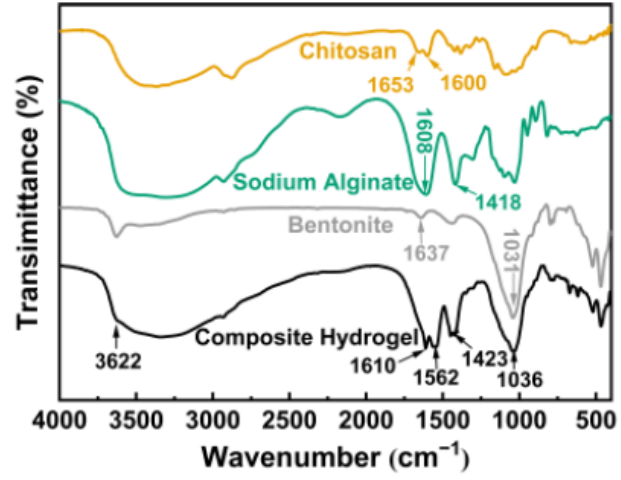
Figure 2. FT-IR spectra of CTS, SA, BT and CTS/CA/BT composite hydrogel.